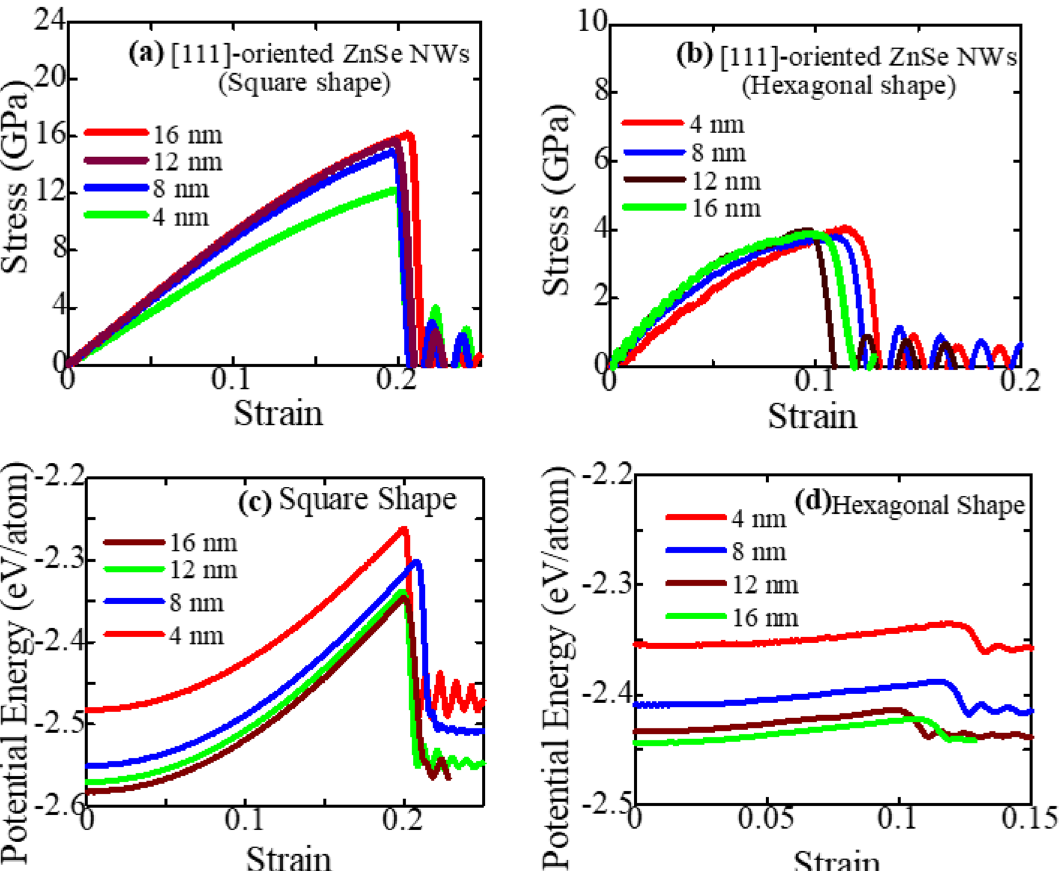
Figure 3. Effect of thickness or diameter on the stress–strain response curves of [111]-oriented zinc-blende ZnSe NWs in ( a ) square shape and ( b ) hexagonal shape at 300 K. Thickness-dependent potential energy/atom of